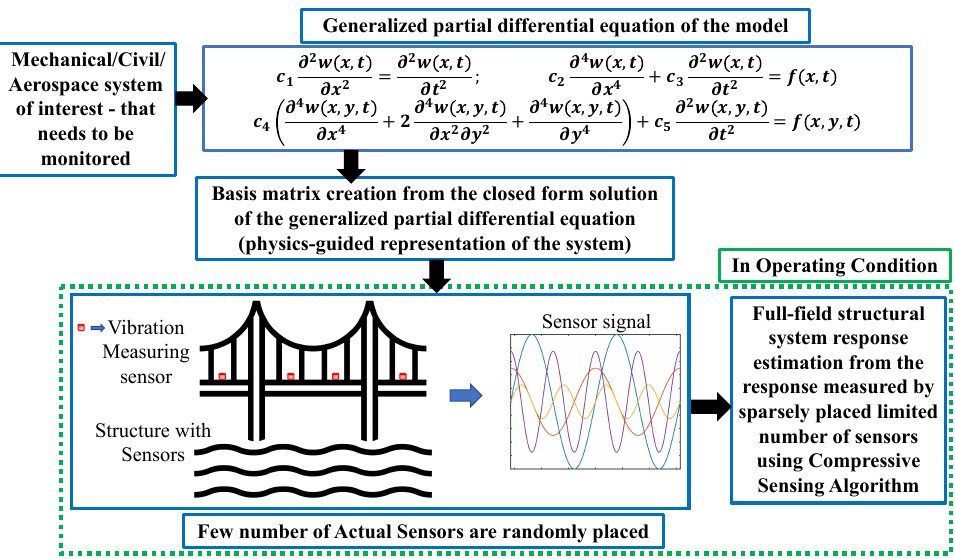
Figure 1. Proposed Methodology. The spatial signal basis functions are obtained from the closed form solution of the generalized partial differential equation of the model (the equations are of transverse vibration of string, beam, and plate, respectively). In operating conditions, the dense responses can be obtained from the responses of the randomly located sensors using Compressive